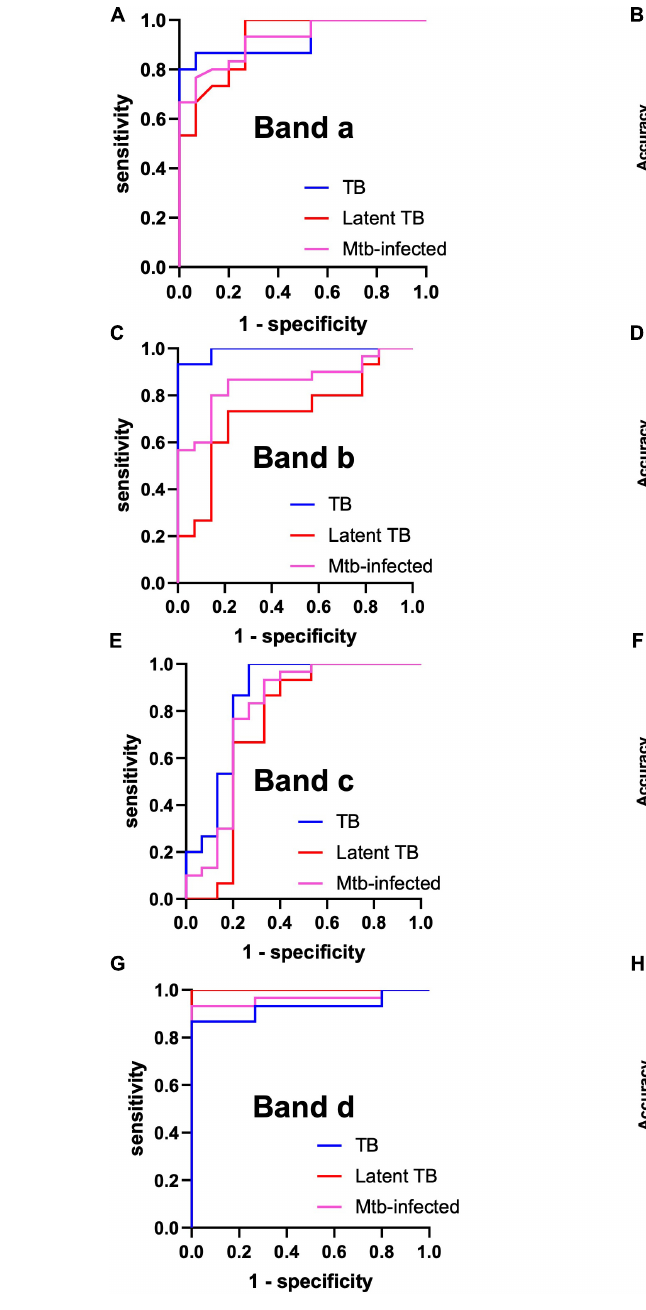
FIGURE 5 | Perfomance analysis of each reactive band. (A,C,E,G) Receiver-operating characteristic (ROC) curves for each band ( Table 2 ). (B,D,F,H) Optimal threshold analysis based on accuracy measurements for each band and sample type. Lines and numbers indicate the optimal threshold (pixel 2 ) of the indicated band for each sample type. Analyses were performed for bands a, b, and c from High Fe MEV blots, while band d was analyzed from Low Fe MEVs